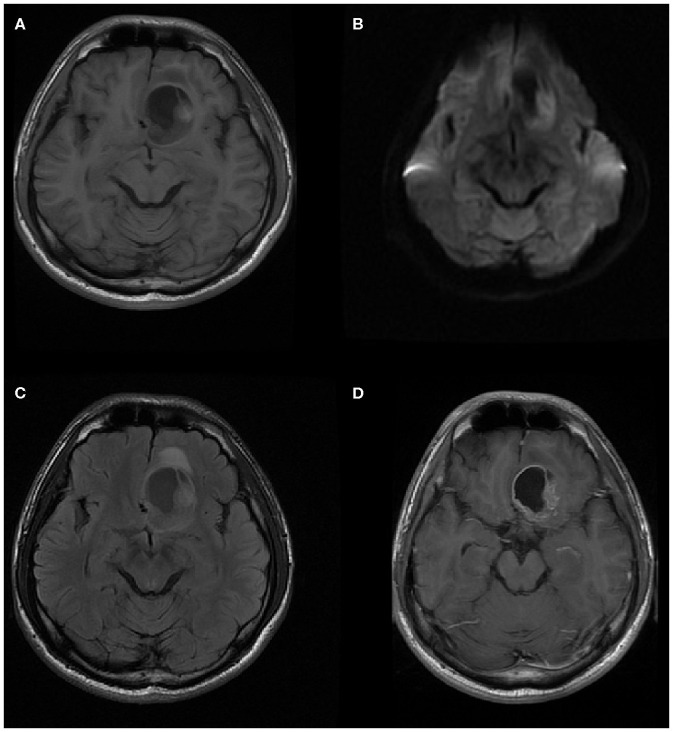
A 20-year-old man with supratentorial intraparenchymal anaplastic ependymoma in the left frontal lobe on (A) T1-weighted image, (B) diffusion-weighted images, (C) fluid-attenuated inversion recovery (FLAIR), and (D) contrast T1-weighted image. The tumor appears as heterogeneous signal intensity, big cysts, reduced diffusion within the soft tissue component, and mild peritumoral edema. There is an area of focal hyperintensity within the tumor, representing hemorrhage.